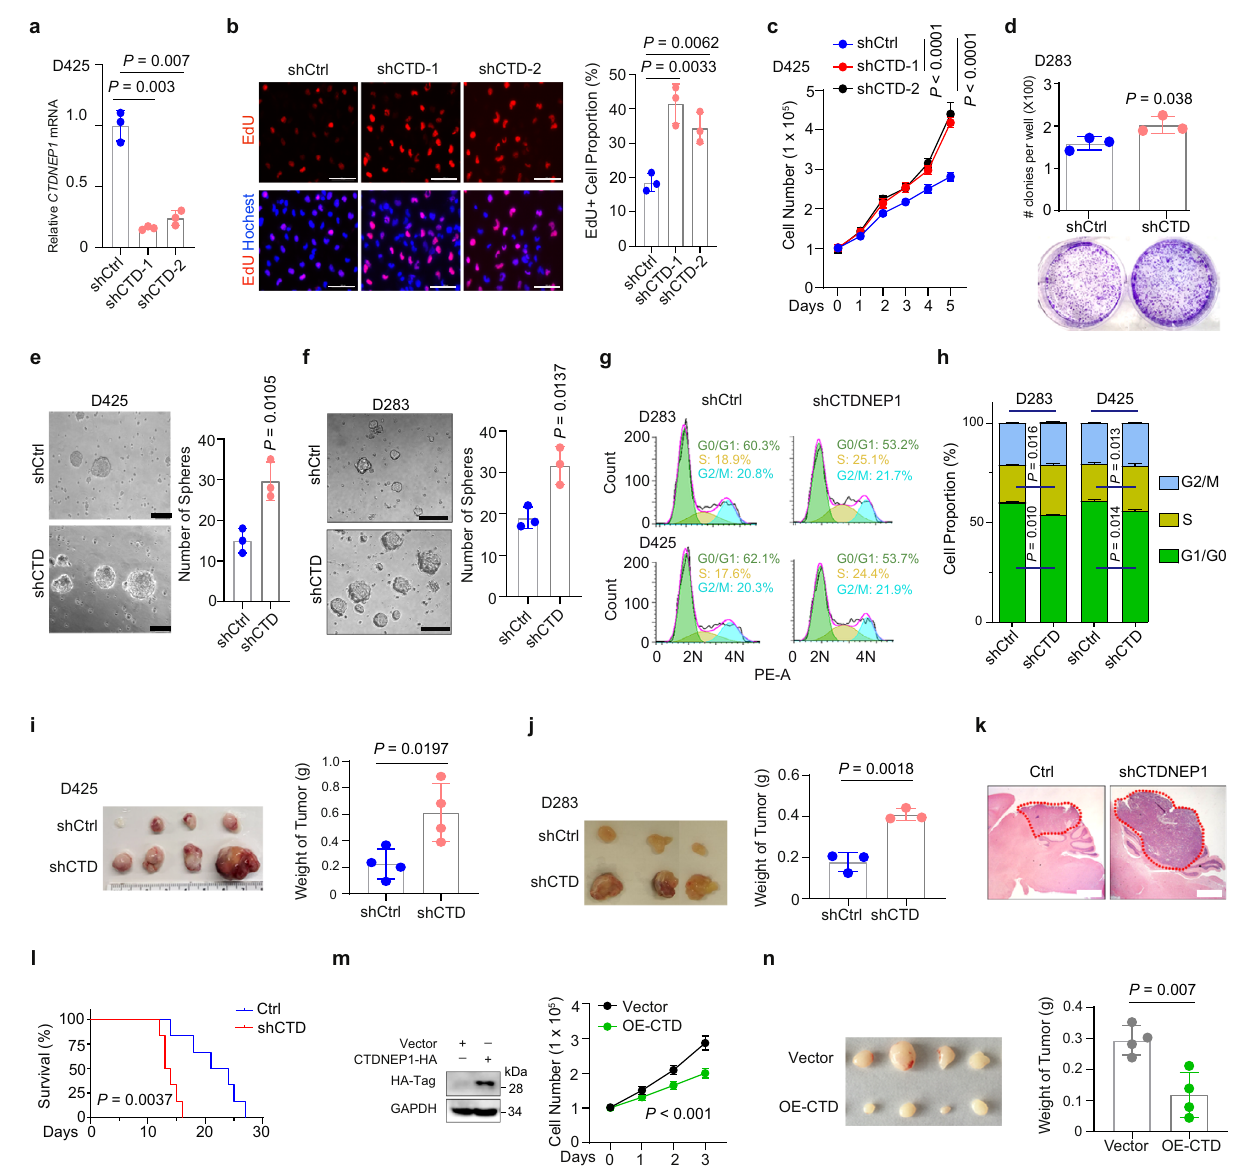
Fig.2|Inhibitionof CTDNEP1 expressionpromotesMBcellproliferation.a qRT- PCR quanti fi cation of CTDNEP1 in D425 cells transduced with lentiviral control (shCtrl) and shRNAs targeted against CTDNEP1 (shCTD). n =3 independent experiments. b Left, representative images of shCtrl and shCTD-transduced D425 cells stained for EdU (scale bar, 50 μ m); right, quanti fi cation of EdU + cells. n =3 independent experiments. c Growth of shCtrl and shCTD-transduced D425 cells assayed by WST-1. n =6 independent measurements. Two-way ANOVA. d Upper, thenumberofclonesperwellinasoftagarassayofCtrlandshCTDD283cellsafter 10 days culture. Lower: representative images of clones in soft agar plates. n =3 independent experiments. e , f Left: representative images of neurospheres of control and shCTD- transduced D425 ( e ) and D283 cells ( f ). Scale bars, 100 μ m. Right panels: the number of spheres. n =3 independent experiments. g , h Representative fl ow cytometry ( g ) of cell-cycle stages of D283 (upper) and D425 (lower) cells transduced with shCtrl or shCTD. h percentage of cells at